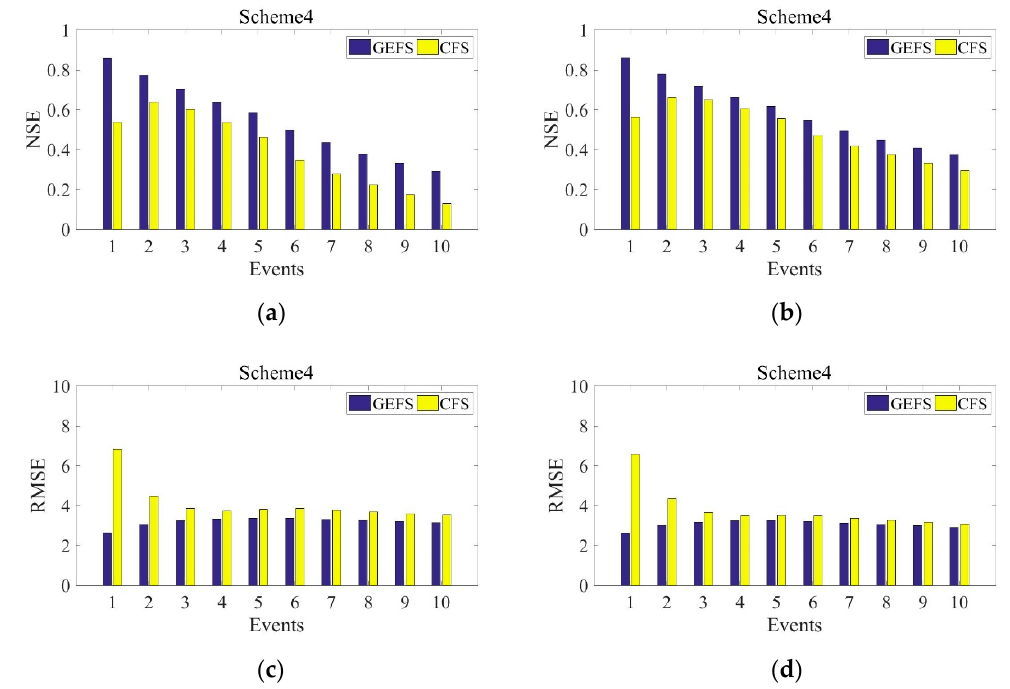
Figure 7. The evaluation results of Scheme 4: ( a ) the NSE of raw forecasts; ( b ) the NSE of post-processed forecasts; ( c ) the RMSE of raw forecasts; and ( d ) the RMSE of post-processed forecasts.